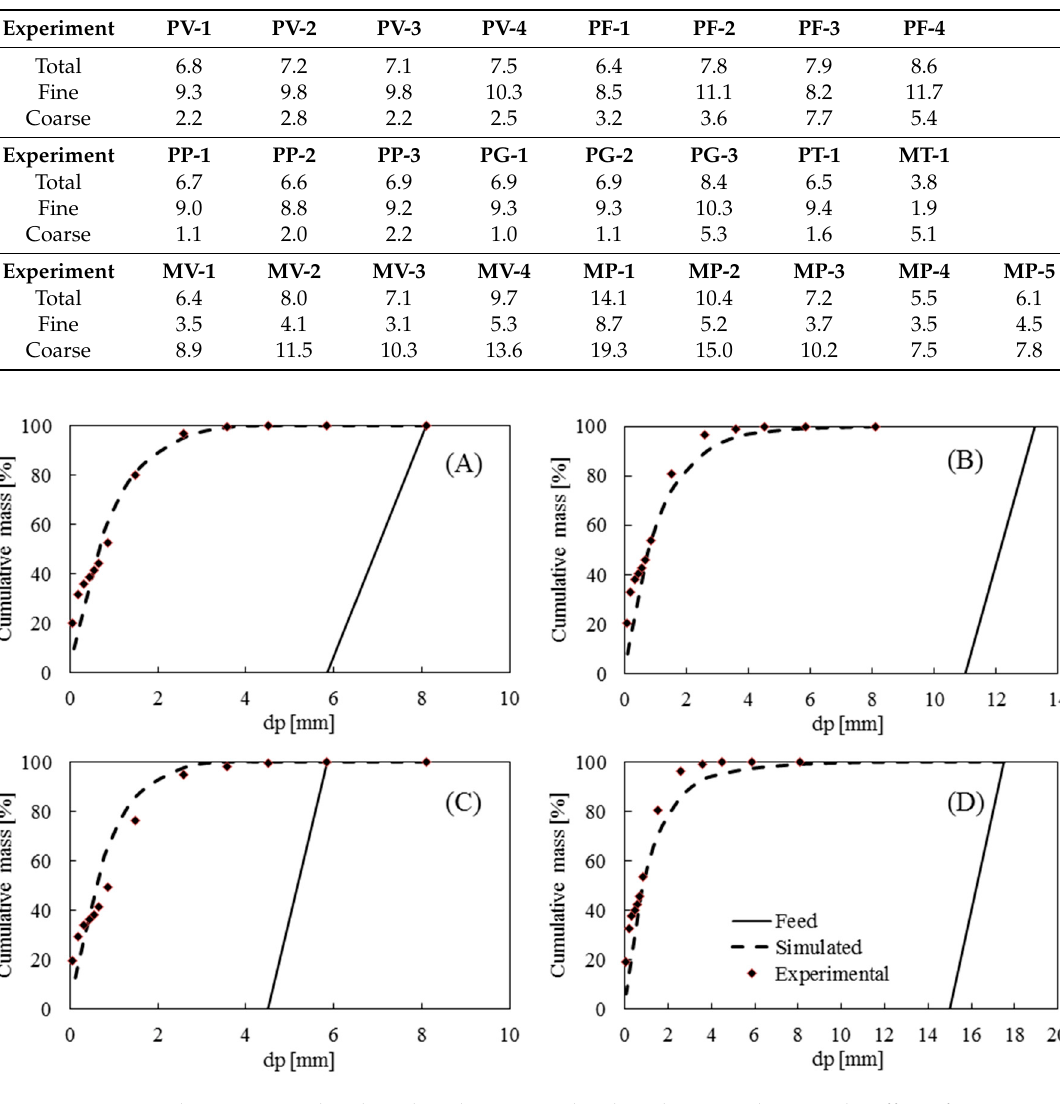
Figure 13. Feed, experimental and predicted curves in the altered granite showing the effect of varying the feed size. ( A ) PF-1; ( B ) PF-2; ( C ) PF-3 and ( D ) PF-4.